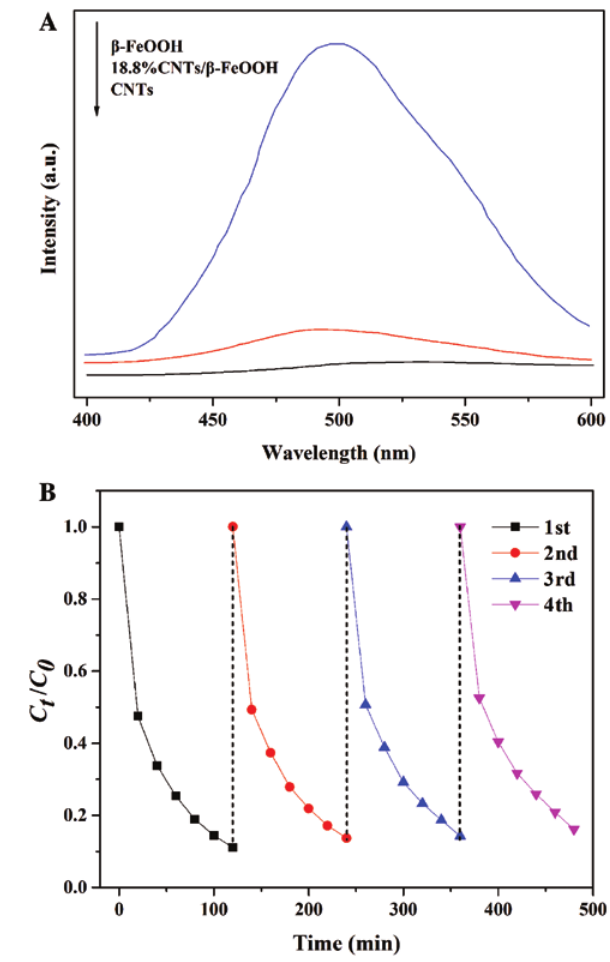
Figure 4: Photoluminescence spectra of CNTs, 18.8%CNTs/ β -FeOOH and β -FeOOH (A); repeated use of 18.8%CNTs/ β -FeOOH in the pho- tocatalytic oxidation of MO under visible light irradiation